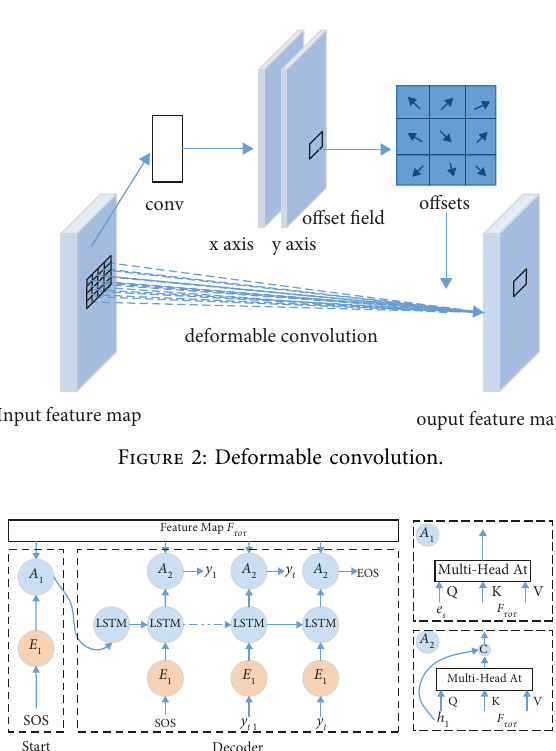
Figure 1: Overall architecture of nonstandard thermal injection code detection and identification.